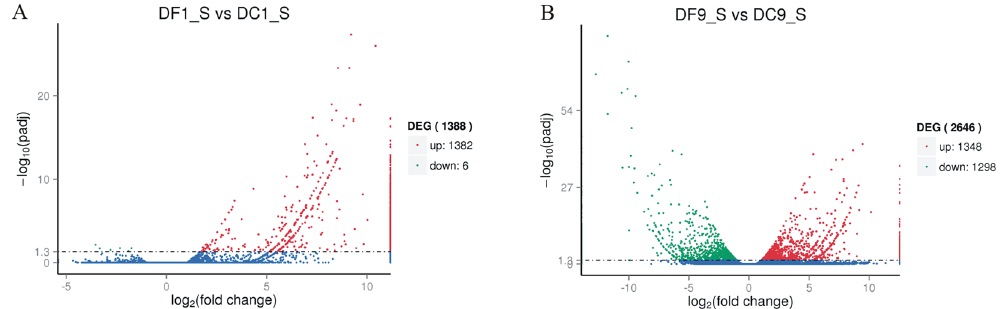
Figure 7. Volcano plots displaying differentially expressed genes between symbiotic and asymbiotic samples. ( A ) DF1_S compared with DC1_S. ( B ) DF9_S compared with DC9_S. The y-axes correspond to the mean expression values of log 10 (p-value), and the x-axes display the log2 fold change values. The red dots represent the up-regulated expressed transcripts (P < 0.05, false discovery rate (FDR) q < 0.05) between DF_S and DC_S; the green dots represent the transcripts whose expression levels were down-regulated (P < 0.05, FDR q <